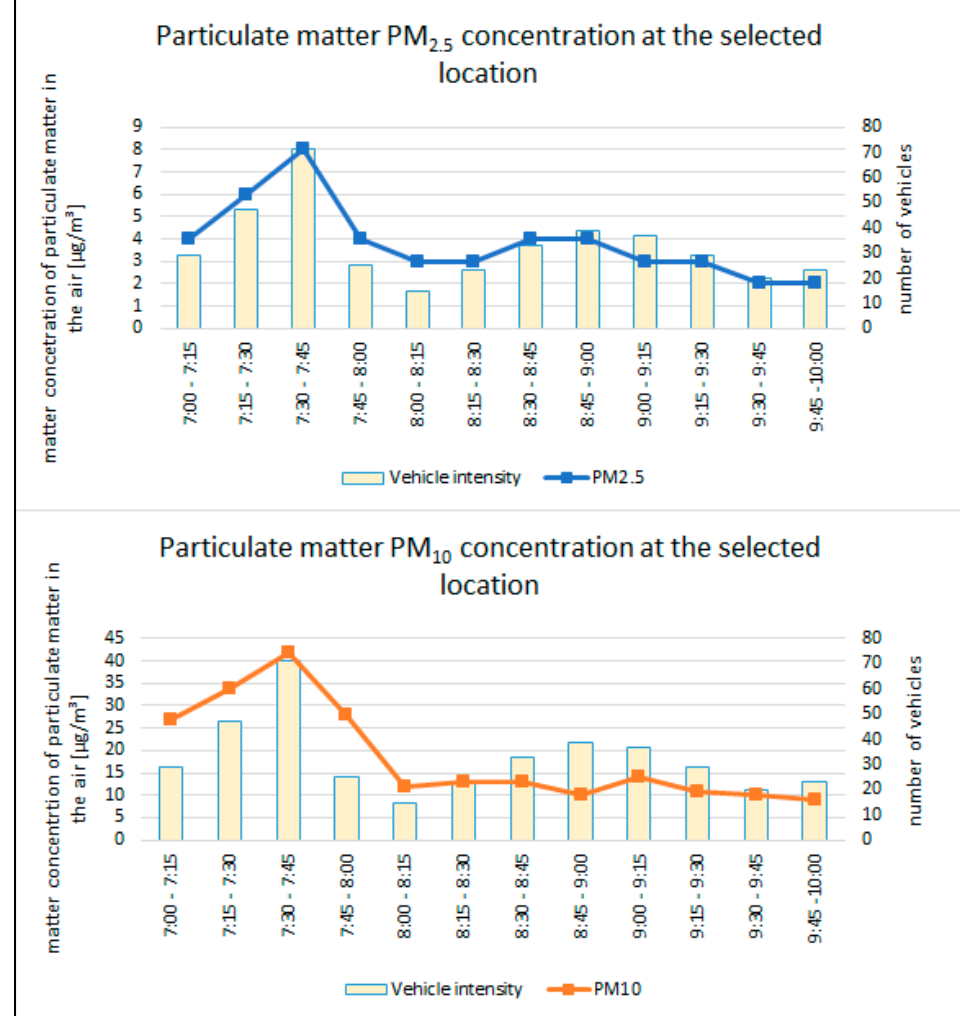
Figure 6. Particulate matter concentrations at selected location—primary school.